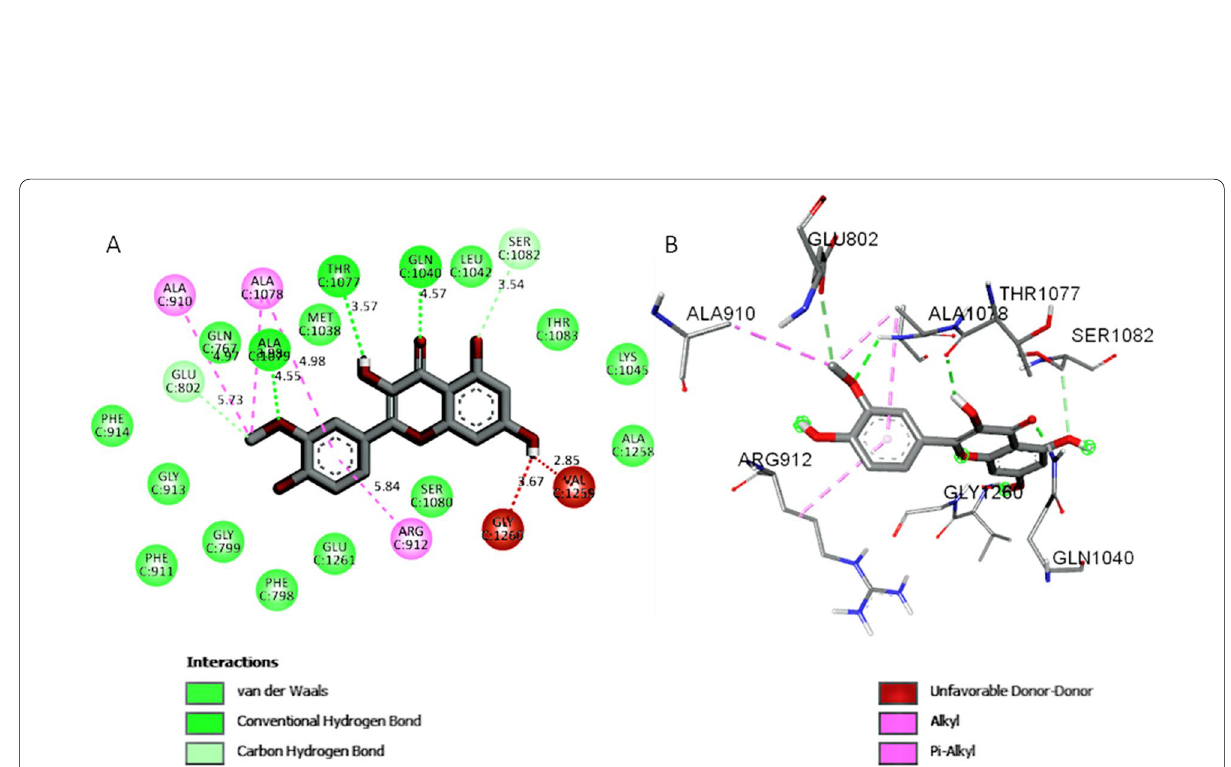
Fig. 7 2D ( A ) and 3D ( B ) simulations of isorhamnetin–XOD active site supramolecular bondings, showing a pi-alkyl interaction with the substrate-binding ARG912 and a carbon–hydrogen interaction with the catalytic